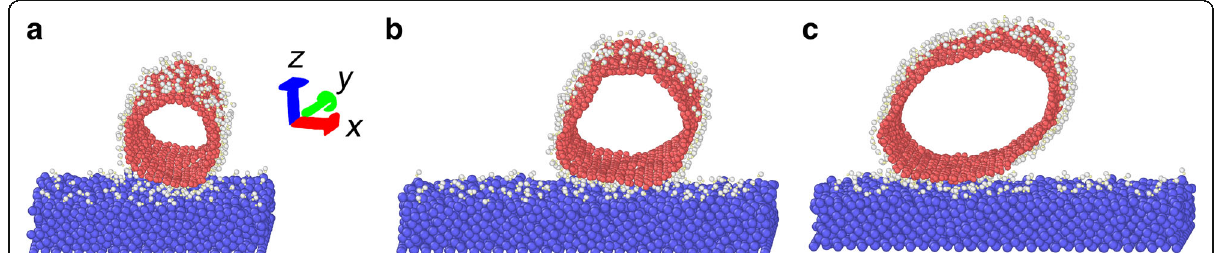
Fig. 5 The structure of carbon nanotube on Si substrate. a SWCNT (15,15). b SWCNT (20,20). c SWCNT